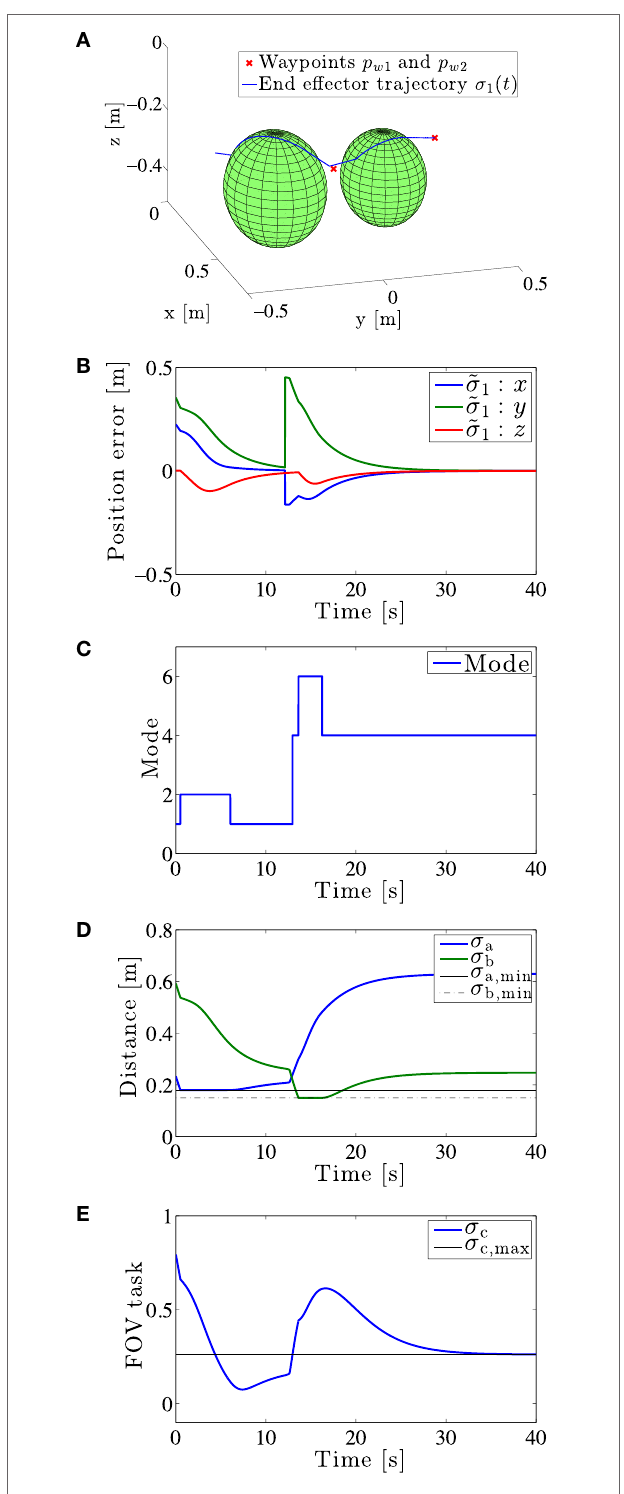
FIGURE 5 | Logged data from Example 1 . (A) End-effector trajectory. The two waypoints plotted in red. The figure shows that the end-effector moves around the obstacles to reach its desired position. (B) Position error ~ (cid:27) 1 in x , y , and z -direction. (C) Active mode over time. (D) End effector distance to the two obstacle centers. (E) Field of view